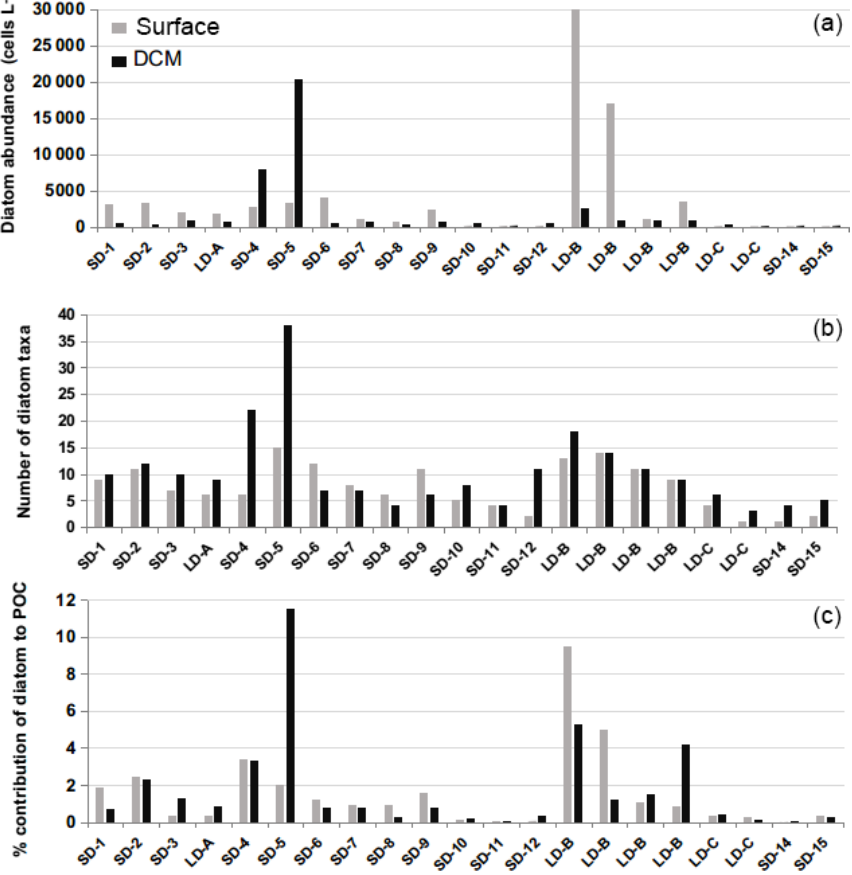
Figure 9. Diatoms cellular concentrations (cellsL − 1 ) derived from (a) , Niskin cell counts, (b) number of taxa and (c) relative contribution to POC biomass (%) at the surface and DCM levels during the OUTPACE